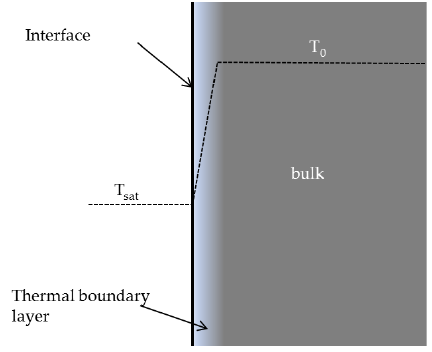
Figure 1. Temperature profile in the thermal boundary